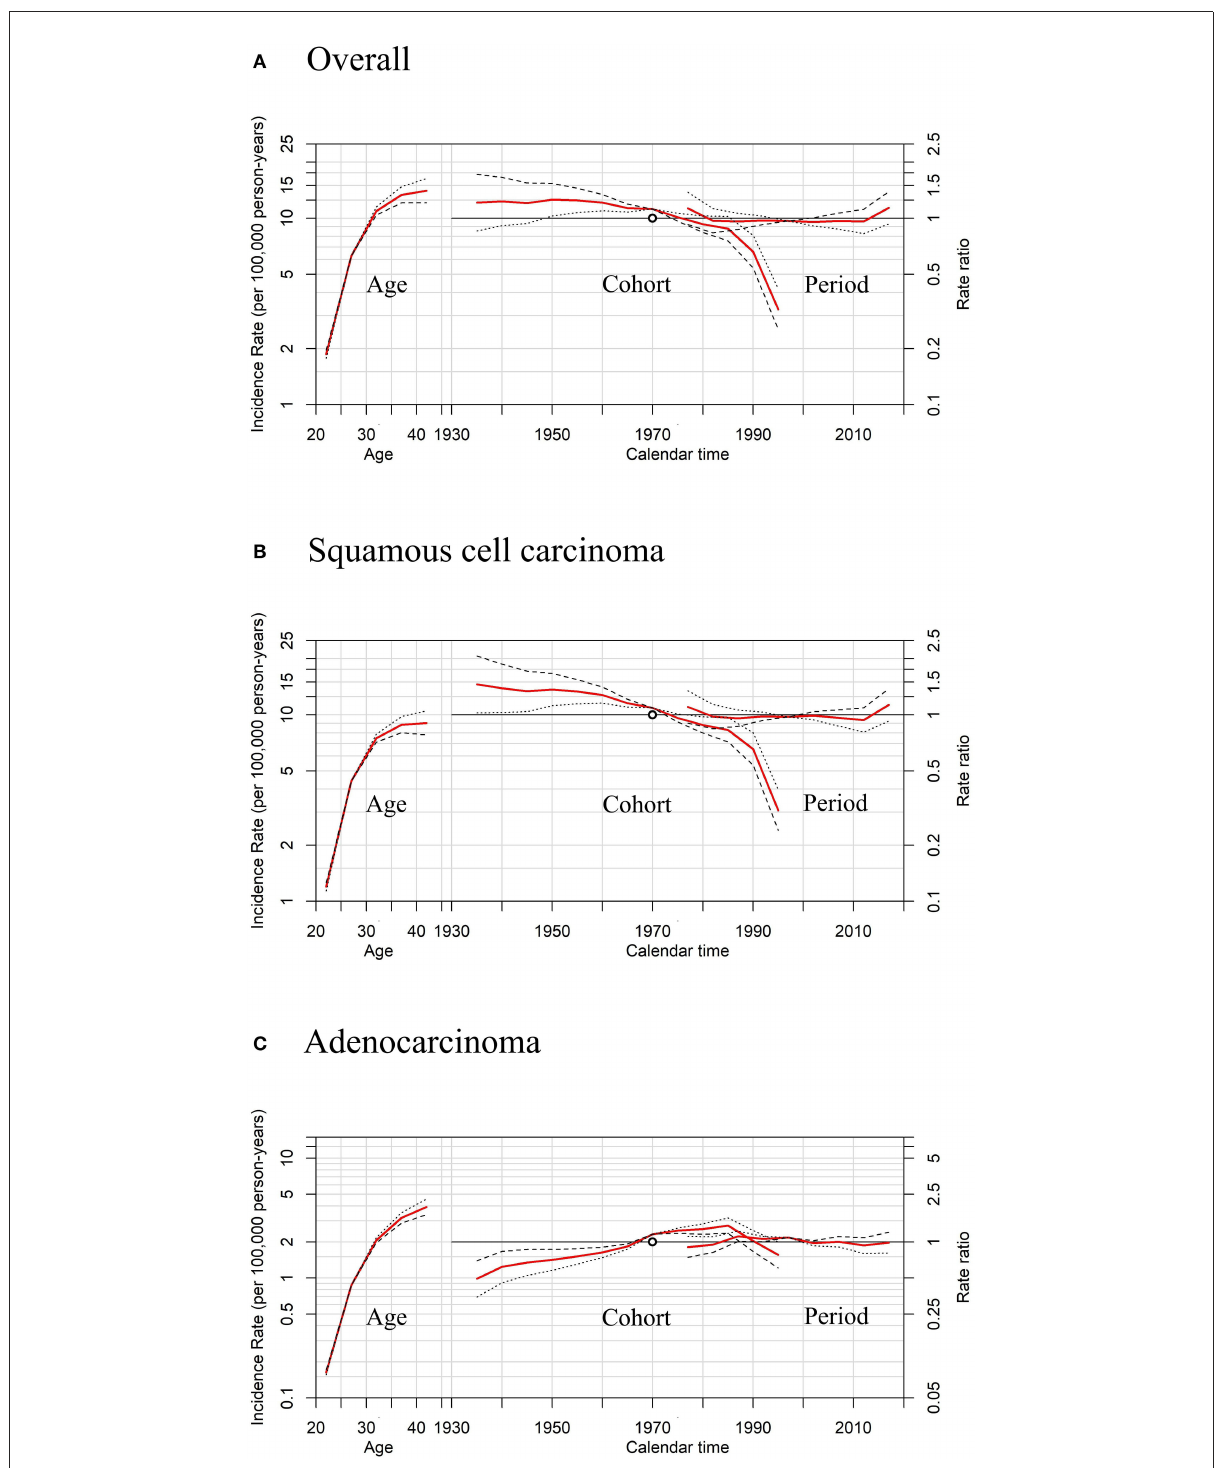
FIGURE7 Sensitivity analyses of age-period-cohort model in cervical cancer incidence rates among females aged 20 to 44 years by histology, United States. (A) Results of all histopathologic subtypes combined. (B) Results of squamous cell carcinoma (SCC). (C) Results of adenocarcinoma (AC).The slope of the period effect was assumed to be β = 0 (solid lines), − 0.01 (dotted lines), and + 0.01 (dashed lines) to analyze the cohort effect. The scale on the left axis is for age effect. The scale for the cohort and period effects is on the right axis. The empty circle represents the reference cohort of 1970 (median date of birth among cervical cancer